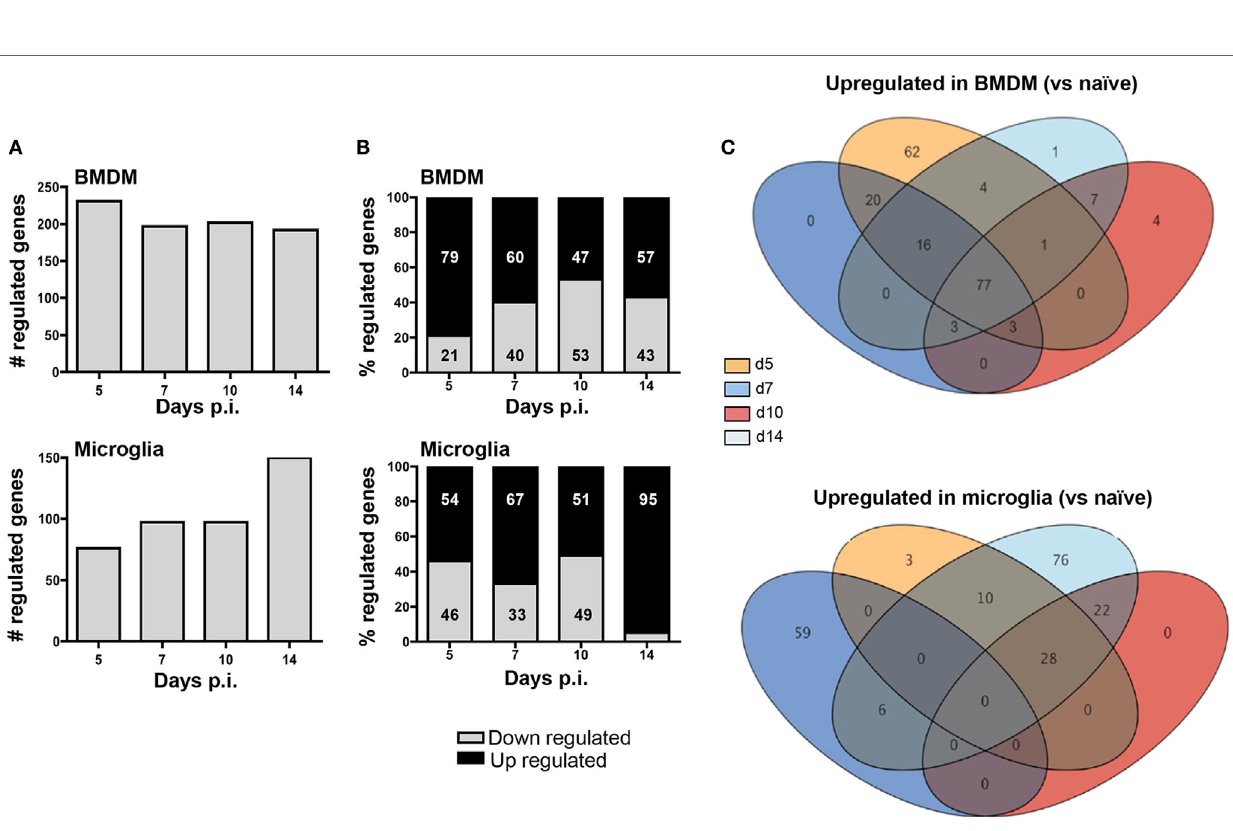
FigUre 5 | Infiltrating bone marrow-derived macrophage (BMDM) and microglia reveal distinct gene regulation following JHMV infection. BMDM and microglia gene expression patterns obtained from infected mice described in Figure 4 were analyzed for (a) the number of total regulated genes and (B) the relative distribution of up- and downregulated genes (percentage of increased and decreased) within each population. (c) The Venn diagram represents the number of genes upregulated at least twofold relative to the naïve populations throughout days 5, 7, 10, and 14 p.i. in BMDM and microglia. Numbers in overlapping ellipses represent genes upregulated at several time points.